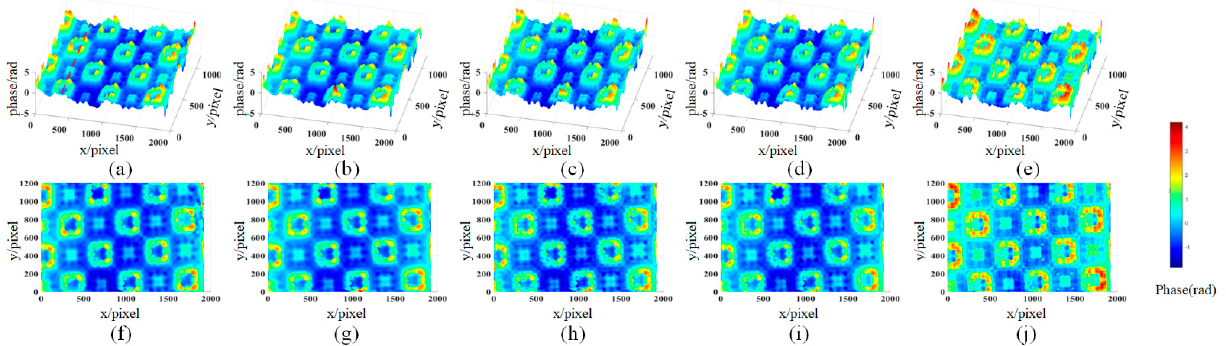
Figure 7. The reconstructed phase maps of sample plate interferogram. ( a – d ) 3D display of the reconstructed phase maps after processing Figure 4b by the method proposed in this paper, the improved P-M equation method with Canny operator, the mean filter method and the median filter method, respectively. ( e ) The 3D display of the reconstructed phase map of Figure 4b without denoising. ( f – i ) The 2D display of the reconstructed phase maps after processing Figure 4b by the method proposed in this paper, the improved P-M equation method with Canny operator, the mean filter method and the median filter method, respectively. ( j ) The 2D display of the reconstructed phase map of Figure 4b without